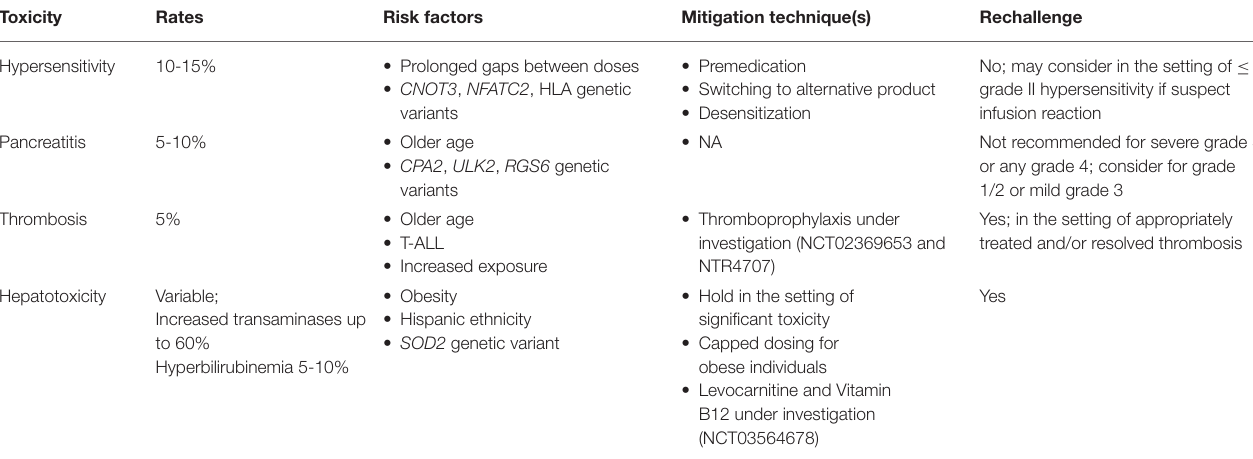
TABLE 2 | Prominent asparaginases